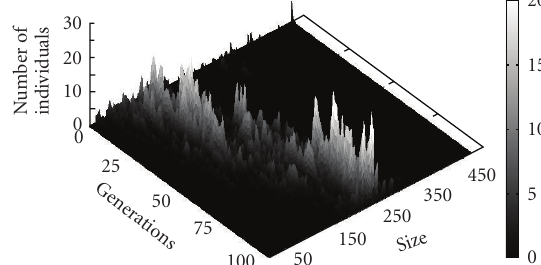
Figure 6: Symbolic regression Experiment 1: chromosome size in the